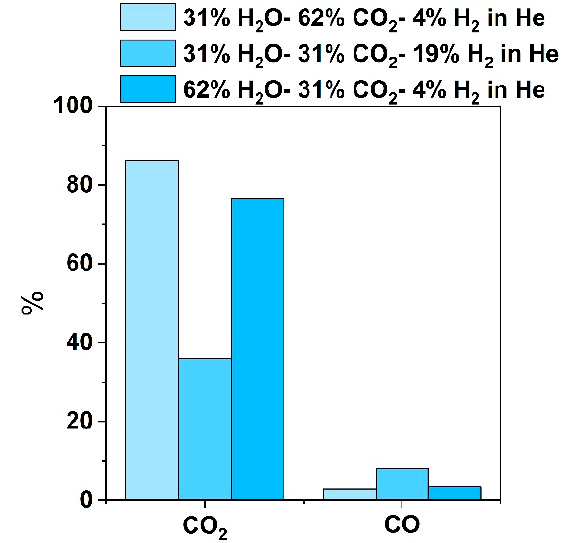
Figure 8. Outlet composition of CO 2 and CO in the outlet steam (dry basis analysis) under the galvanostatic operation of the button cell at a current density of 250 mA cm − 2 for the three different cathode feed mixtures with an increasing S/C ratio from 0.5 to 2, at 900 °C. The H 2 /CO ratio in the outlet cathode stream for both cases (H 2 presence or absence in the feed) is given in Figure 9. When H 2 is fed to the cathode, the ratio of H 2 /CO in the produced syngas is defined by the S/C inlet ratio rather than the applied current [8]. For S/C = 1 and 2 ratios, synthesis gas is produced with a similar composition, i.e., an H 2 /CO ratio of 1.5–2, while when the inlet has an S/C = 0.5 the resulting syngas has a composition of H 2 /CO 0.5–0.8